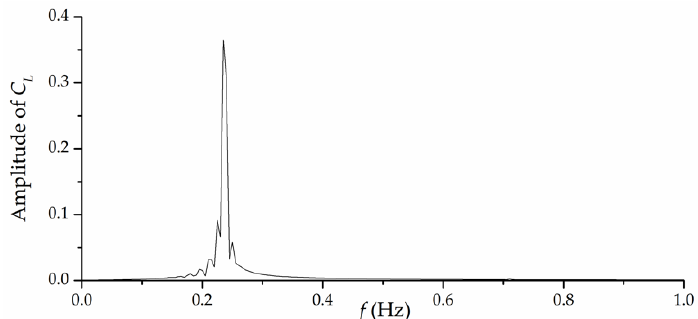
Figure 7. Fourier transform of SFT lift force coefficient when reduced velocity U r = 2.0 (Re = 50,000, m* = 2.5, ξ = 0.007).